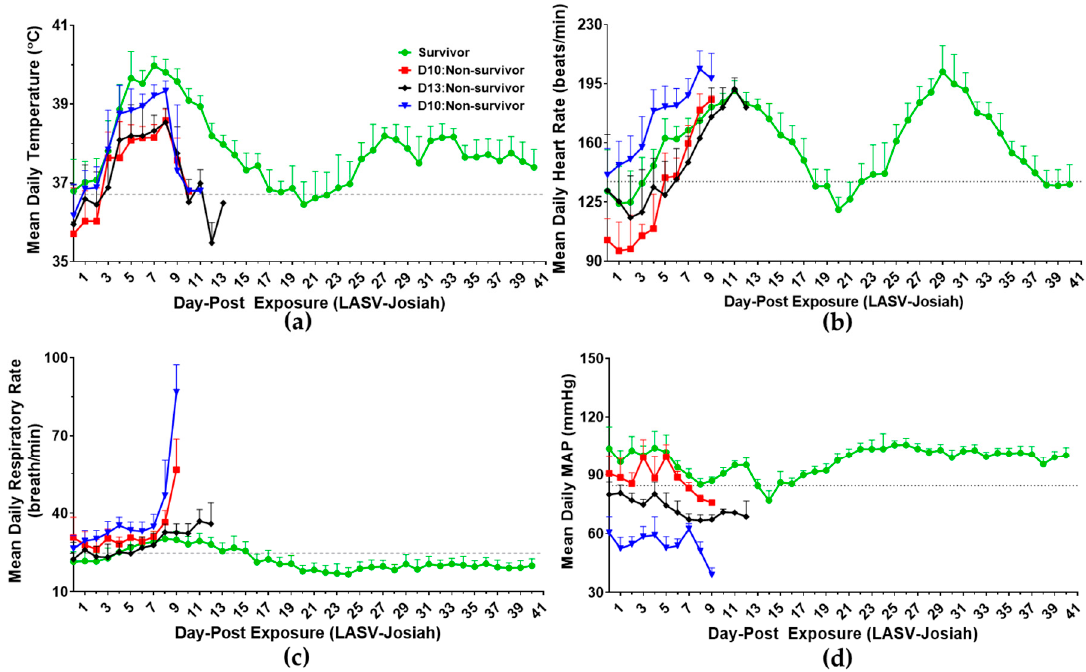
Figure 2. Mean daily telemetric assessment of aerosol Lassa virus infected cynomolgus macaques. Mean daily ( a ) temperature, ( b ) heart rate, ( c ) respiratory rate, and ( d ) mean arterial pressure (MAP). ( ● Survivor) ( ■ D10:Non-survivor) ( ♦ D13:Non-survivor) ( ▼ D10:Non-survivor). Grey dashed line is average relative to each animal for DPE -5 to DPE 0. Error bars indicate standard deviation.